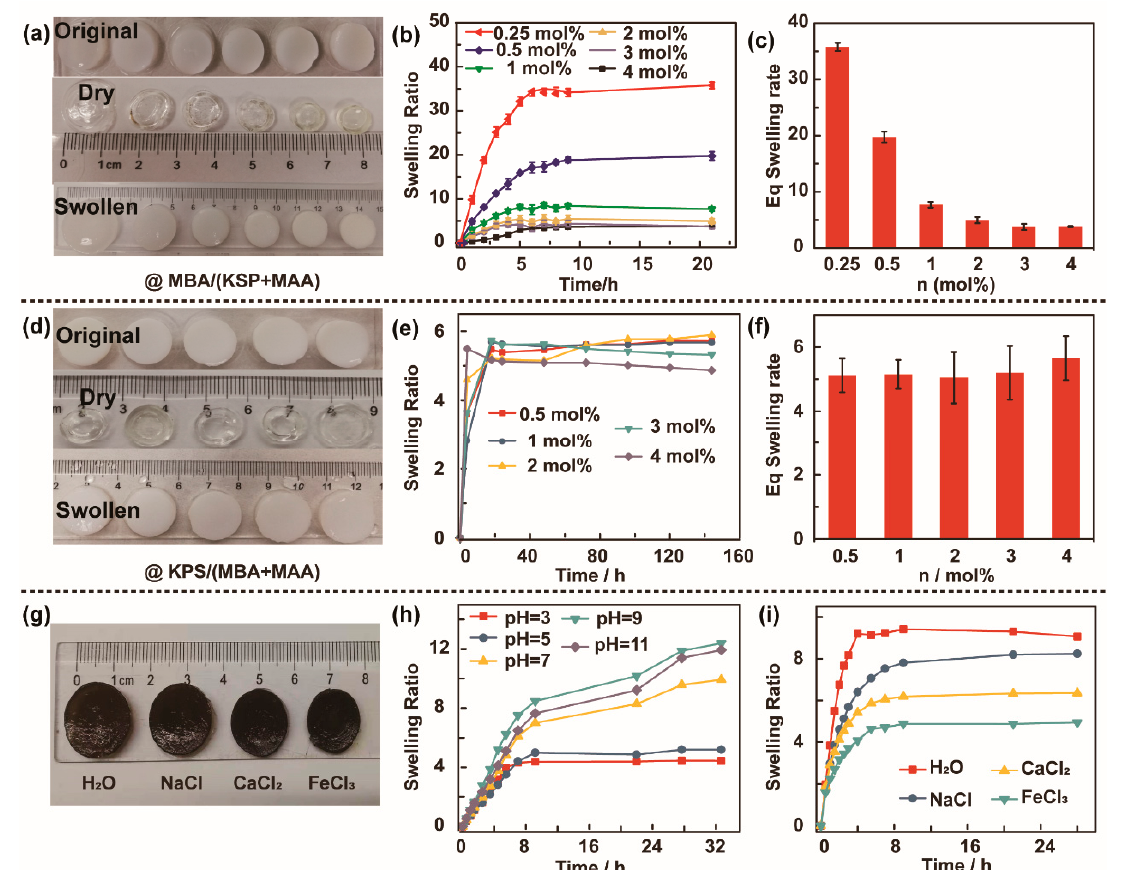
Figure 2. Swelling properties of PMAA hydrogel and PMAA/GO composite hydrogel. ( a – c ) Determination of gel swelling rate with different molar ratios of N,N ′ -methylene-bis(acrylamide) (MBA)/MAA. ( a ) Comparison before and after swelling; ( b ) trend in swelling rate over time; ( c ) the swelling rate corresponding to the swelling equilibrium. ( d ) Comparison before and after swelling; ( e ) trend in swelling rate over time; ( f ) the swelling rate corresponding to the swelling equilibrium. ( g ) Photos of PMAA/GO gels at swelling equilibrium under different salt solutions. ( h ) Influence of pH on swelling rate of PMAA/GO gel. ( i ) The variation in PMAA/GO gel swelling rate with time in different salt solutions.